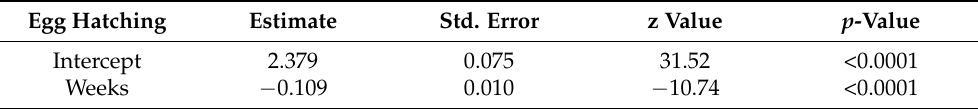
Table 5. Egg hatching rate.